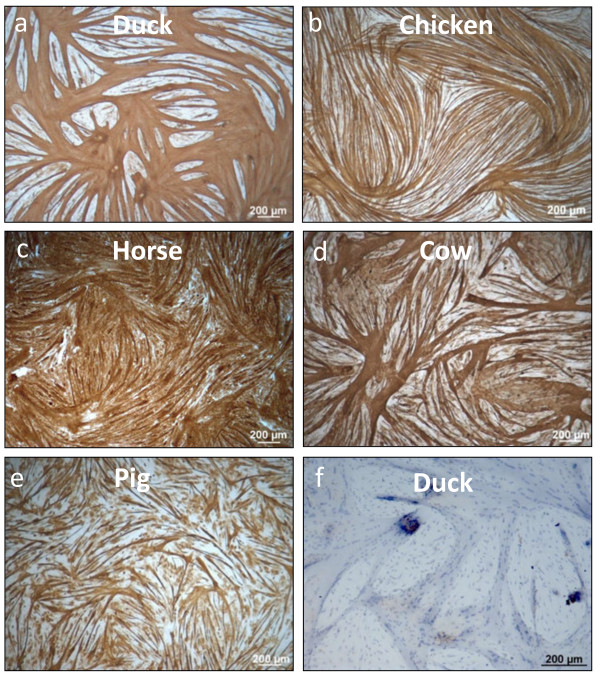
Terminally differentiated primary muscle cultures from different animal species immunolabeled for the muscle-specific intermediate filament desmin. Duck muscle (pectoralis major) cells were cultured for 4 days (a), chicken muscle (pectoralis major) cells for 6 days (b), equine muscle (biceps femoris) cells for 4 days (c), bovine muscle (psoas major) cells for 3 days (d), porcine muscle (psoas major) cells for 4 days (e). No primary antibody control duck muscle cells (f) was counterstained with Harris’ Haematoxylin. Note: days of culture are counted from seeding day 0.